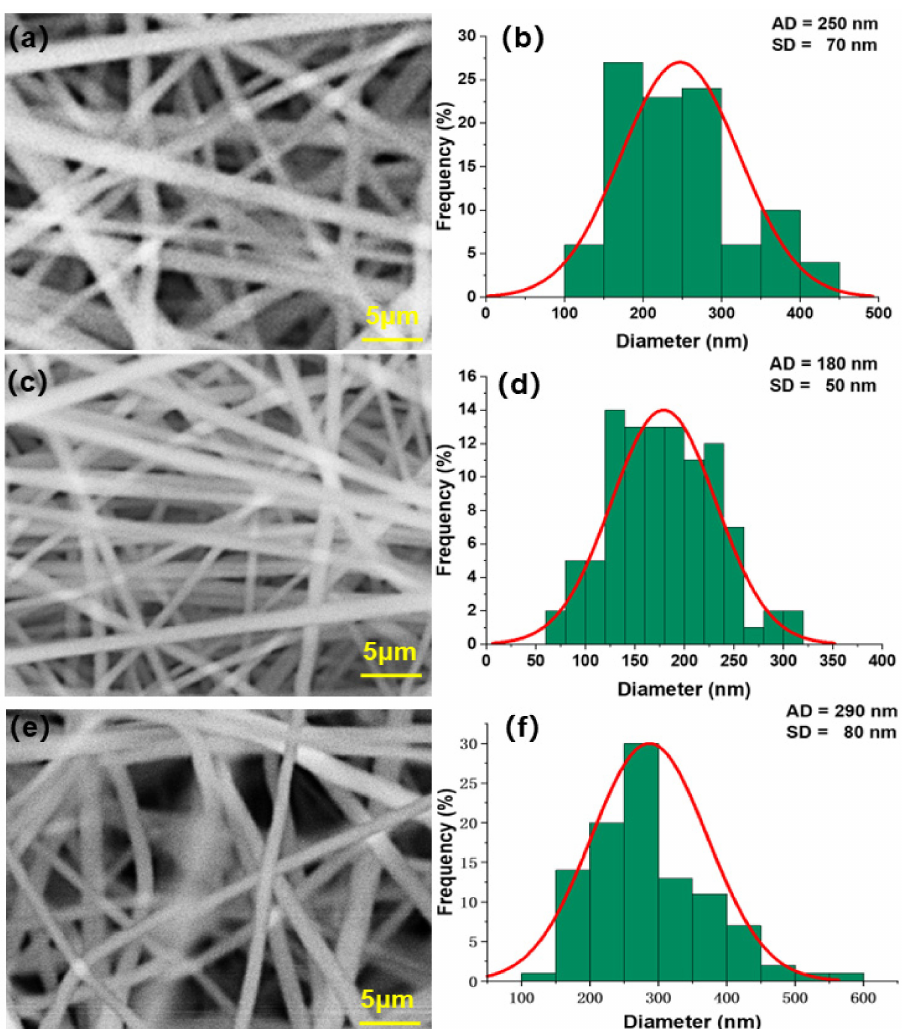
Figure 3. SEM morphology and fiber diameter frequency distribution of nanofiber membrane electrospun by PVDF solution at different concentrations. ( a ), ( c ) and ( e ) are SEM images of nanofiber membranes prepared by PVDF solution at 14%, 18% and 22%, respectively; ( b ), ( d ) and ( f ) are the fiber diameter frequency distributions of nanofiber membranes prepared by PVDF solution at 14%, 18% and 22% concentrations,